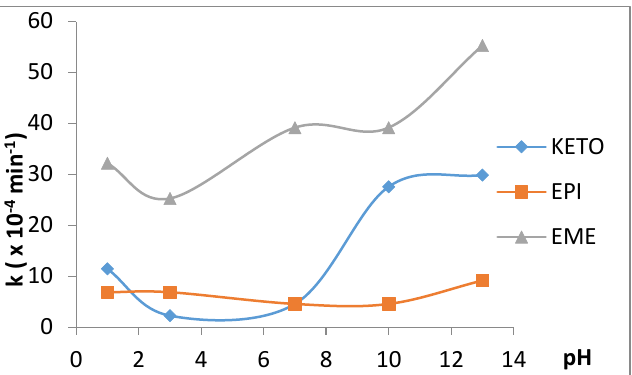
Figure 11. pH rate profiles for degradation of ketotifen (KETO), epinastine (EPI) and emedastine (EME) at 70 °C.